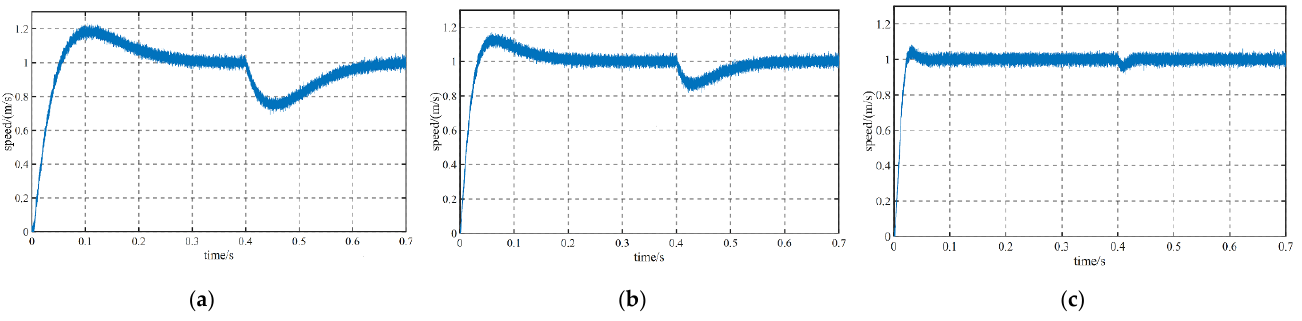
Figure 17. Comparison of velocity waveforms of the 3 systems under sudden loads: ( a ) PI system; ( b ) SMC system; and ( c ) MPC system.